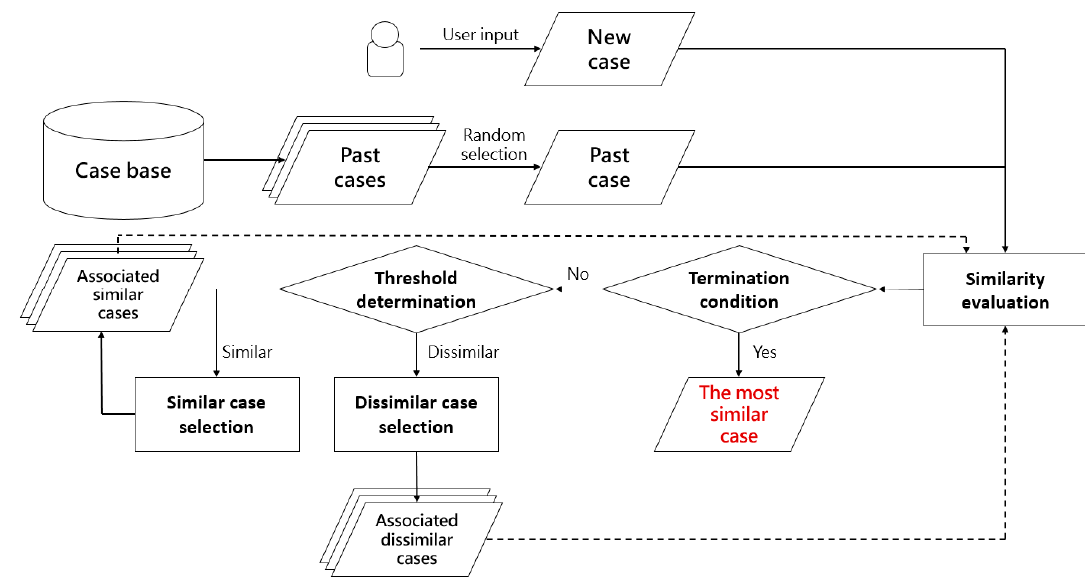
Figure 10. The workflow of fast case retrieval under the proposed associated case